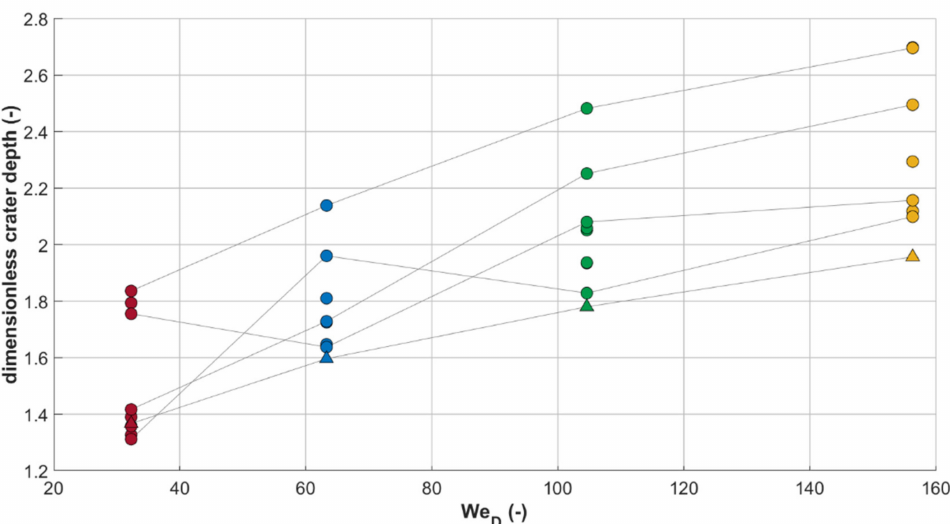
Figure 12. Maximum dimensionless crater depths for multiple drop impacts as a function of the Weber number. Circle markers are used for the points corresponding to the simulations with between four and nine drops, while the triangle markers for the results from the 30 drop simulations; the colors are related to the different impact velocities (brown 1.0 m/s, dark cyan 1.4 m/s, green 1.8 m/s, yellow 2.2